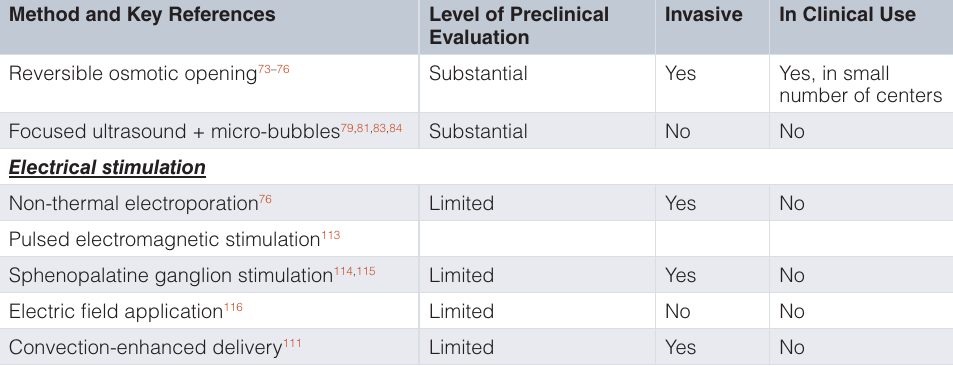
Table 2. Modulation of integrity of blood-brain barrier as method of drug delivery to the brain. Method and Key